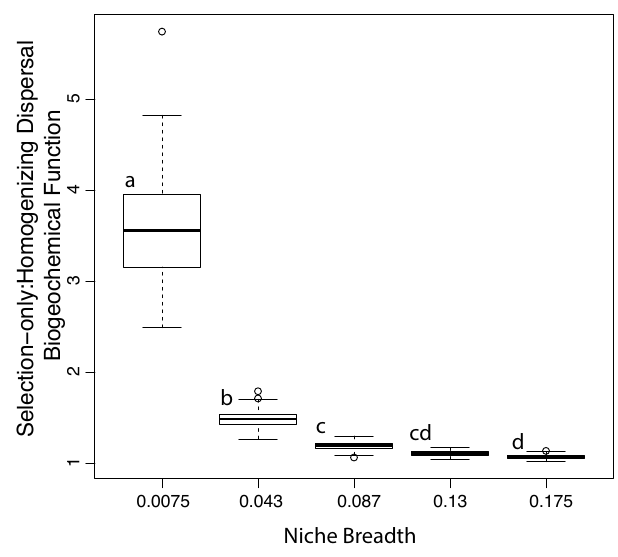
Figure 5. The ratio of biogeochemical function in selection-only cases to homogenizing dispersal cases across five niche breadths that span the entire parameter range (0.0075 to 0.175). Each column represents all replicates across all environments for a given niche breadth. Different letters indicate statistically significant differences in mean values. Upper and lower hinges of the box plots represent the 75th and 25th percentiles and whiskers represent 1.5 times the 75th and 25th percentiles,